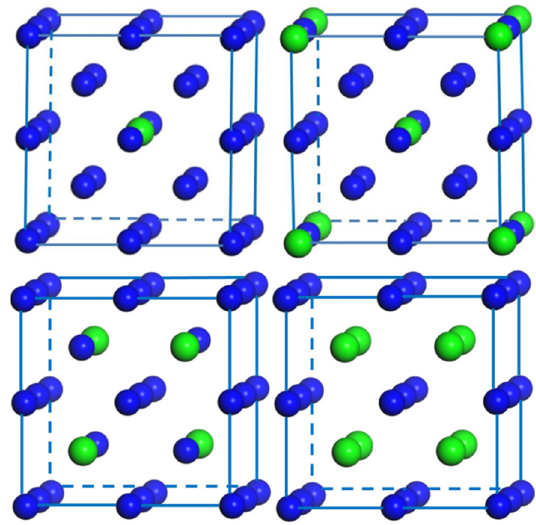
Figure 2. Schematic representation of energetically the most favorable atomic arrangements of the bcc W 1 − x M x ( x = 0.0625, 0.125, 0.25 and 0.5) in a 2 × 2 × 2 supercell. Small blue and large green balls represent W and M (Y, La, Ce or Lu) atoms, respectively.